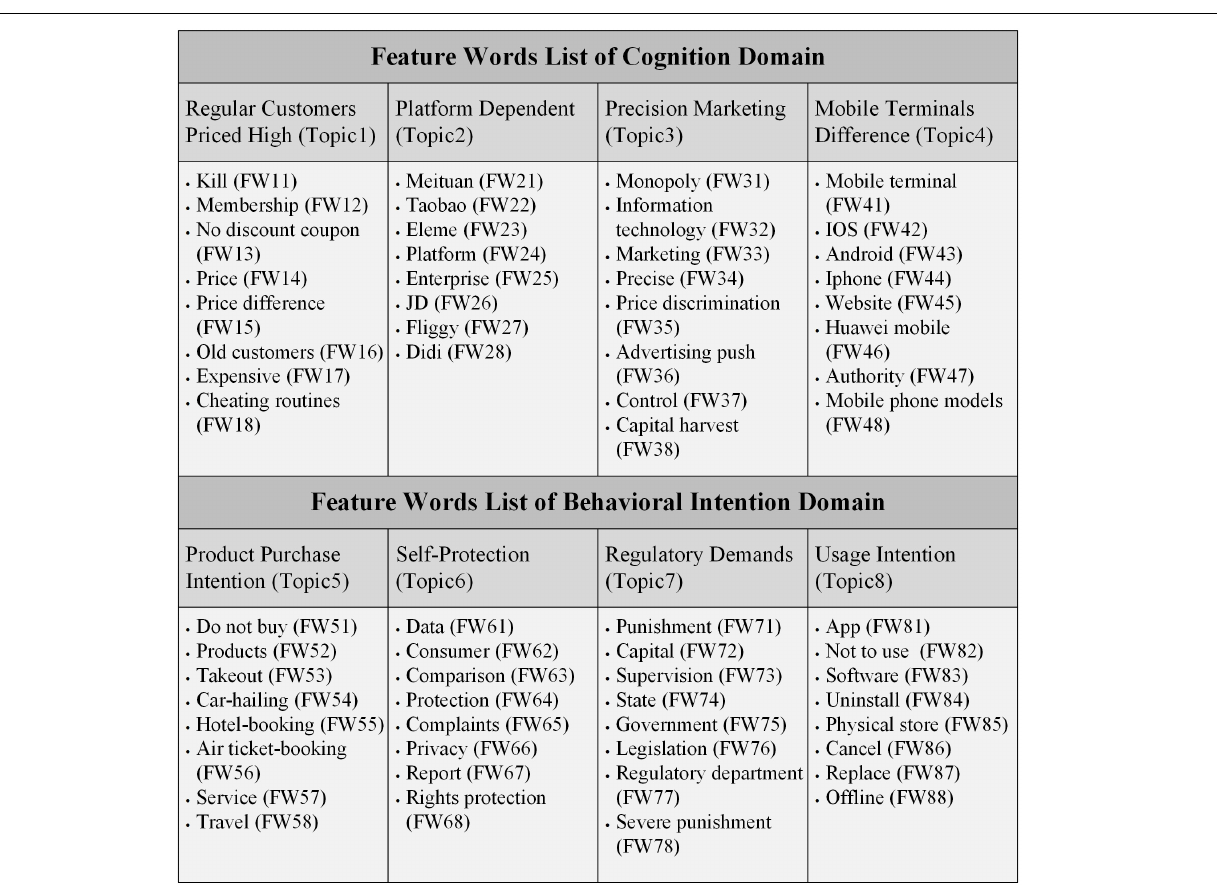
FIGURE 6 | The feature word lists of the target